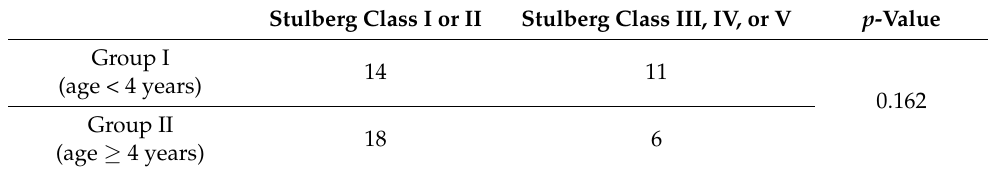
Table 3. Outcome according to age.